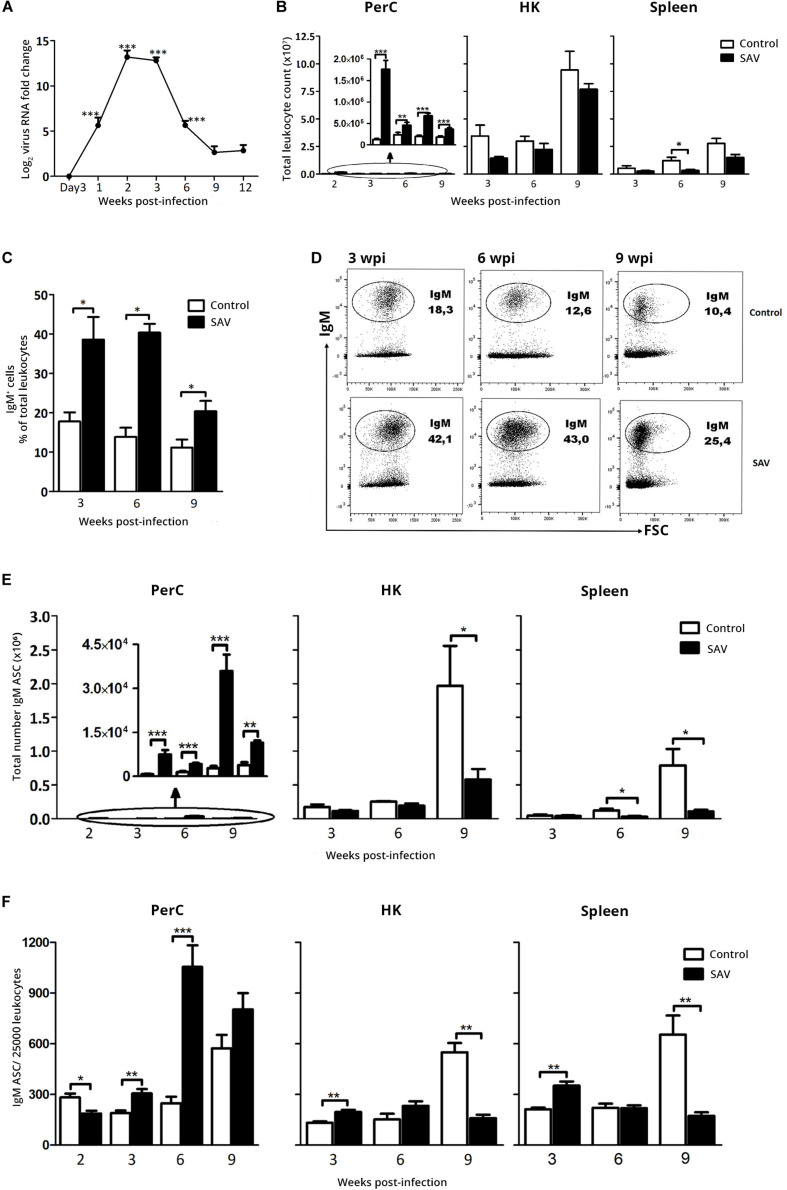
IP SAV3 infection promotes long-term B cell responses in the PerC of Atlantic salmon. (A) SAV3 nsP1 RNA levels in the heart from three days to 12 weeks post infection were analyzed by RT-qPCR. Presented as mean + SEM of fold-change (2–ΔΔCt method) (n = 8). (B) Total leukocyte count for PerC, HK, and spleen from control and SAV3 infected fish (n = 5–10). (C) IgM+ B cell frequency in PerC was analyzed by Flow cytometry presented as mean + SEM (n = 3–6). (D) A representative cytogram showing the frequency of IgM+ cells in the PerC of control and SAV3 infected fish. IgM ASC was analyzed by ELISpot in the PerC, HK, and spleen from control and SAV3 infected fish (n = 5–10) presented as (E) total IgM ASC per site or (F) IgM ASC frequency per 25,000 leukocytes. Statistical significance between control and SAV3 groups are indicated by brackets. Asterisks indicate strength of significance: * p < 0.05, **p < 0.01, and ***p < 0.001. The graph embedded in “PerC” shows the difference in total leukocyte and IgM ASC count over time on a different y-axis scale.